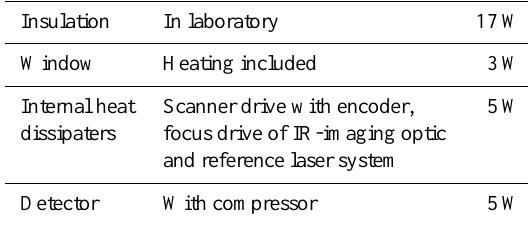
Table 3. Heat load on the cooling